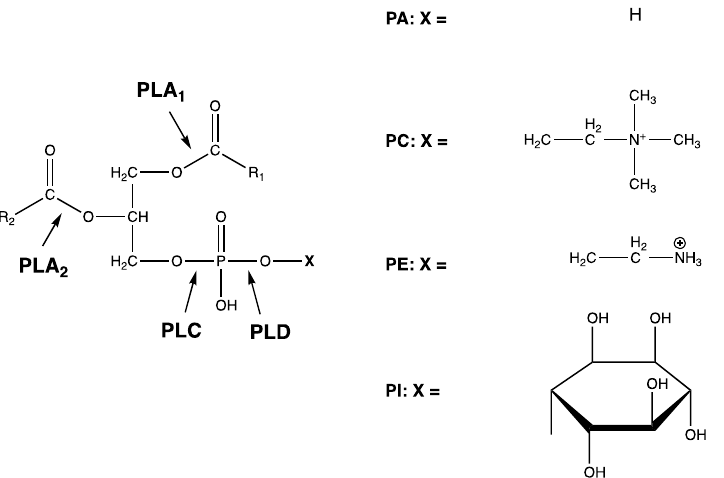
Figure 1. Chemical overview of the action of different types of phospholipases (PL), including PLA 1 , PLA 2 , PLC and PLD. R 1 , R 2 : Fatty acid residues. PA = phosphatidic acid, PC = phosphatidylcholine, PE = phosphatidylethanolamine, PI = phosphatidylinositol.